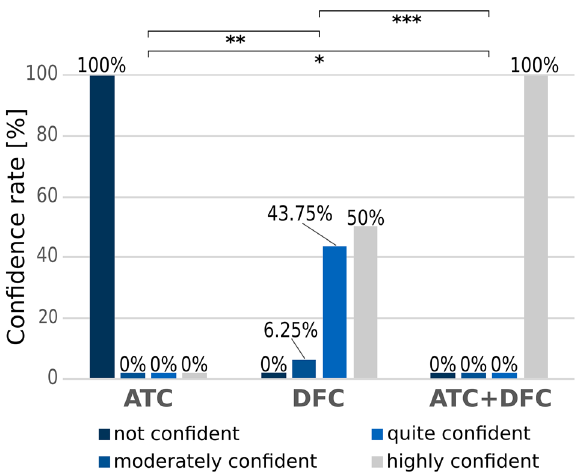
Figure 4. Summary of the confidence ratings given by the readers based on attenuation only (ATC), dark- field only (DFC) and the combination of attenuation and dark-field data (ATC + DFC). There was a significant difference in the confidence scores between the attenuation only and dark-field only (**p = 0.001) as well as the attenuation only and the combined attenuation and dark-field data (*p = 0.001). Between the dark-field only and the combined attenuation and dark-field data, there was no significant difference (***p =